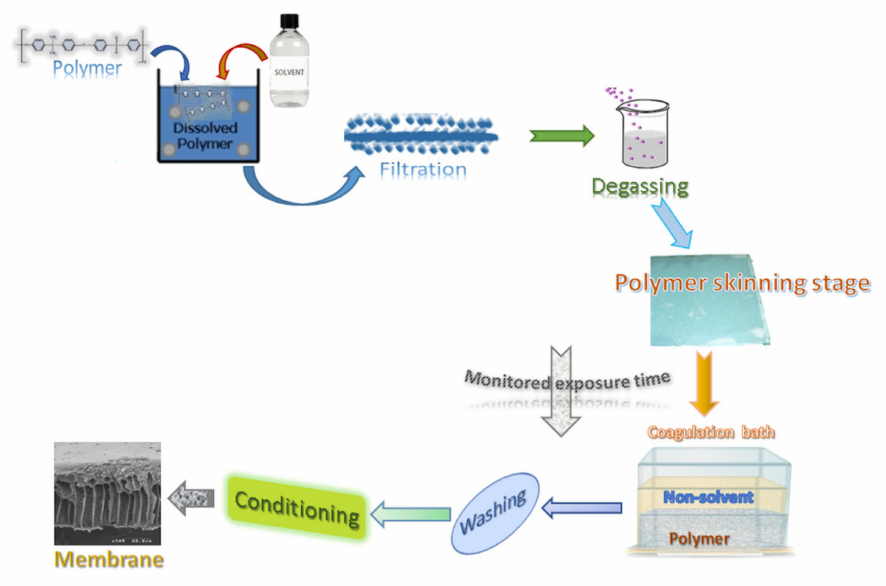
Figure 4. Phase inversion procedure for obtaining polysulfone membranes.